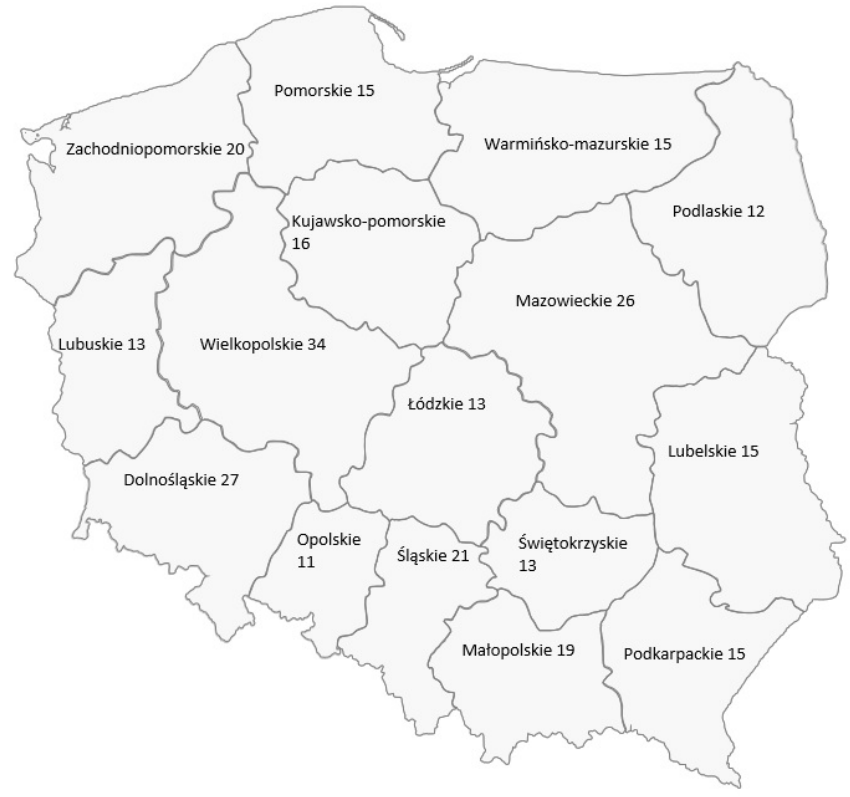
Figure 1. The amount of researched cities in Polish provinces. Source: Author’s own work.